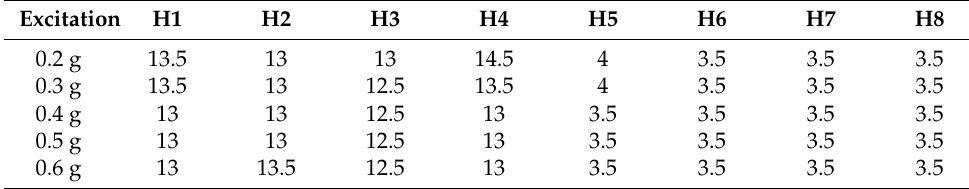
Figure 4. Tip displacement and root mean square (RMS) power measurements versus excitation non-dimensional frequency. Markers represent the measured responses; dashed lines are added to help visualize the experimental trends. Continuous lines represent the linear model predictions for the set of short harvesters. Table 2. Resonant frequency in Hz for the harvesters considered in this